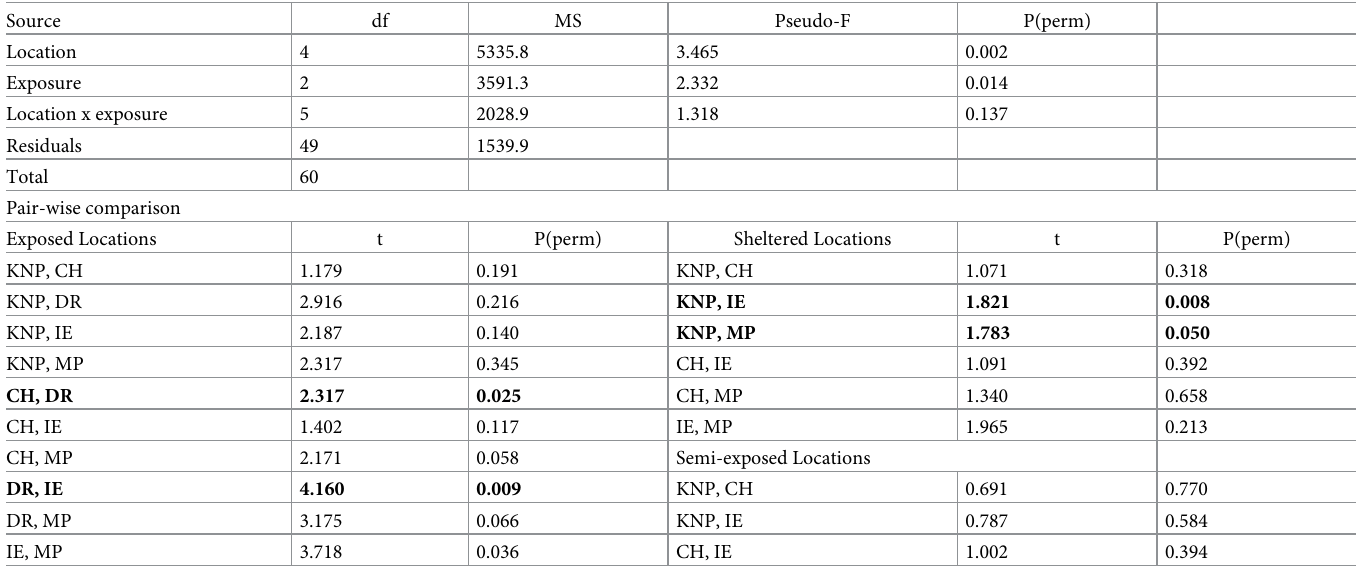
Table 2. Comparison of fish assemblage composition based on density (number of individuals m -2 ) between locations and exposures with permutation-based multi- variate analysis of variance (PERMANOVA). Source df MS Location 3591.3